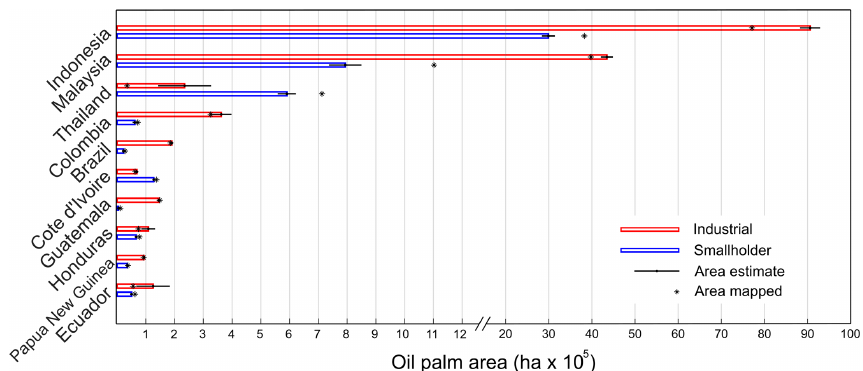
Figure 6. Oil palm plantation area per typology (industrial versus smallholder) for the second half of 2019 in the 10 first countries with the largest oil palm area. The figure reflects the area mapped (asterisk mark), which resulted from the classification of Sentinel-1 and Sentinel-2, and the area estimate with a confidence level of